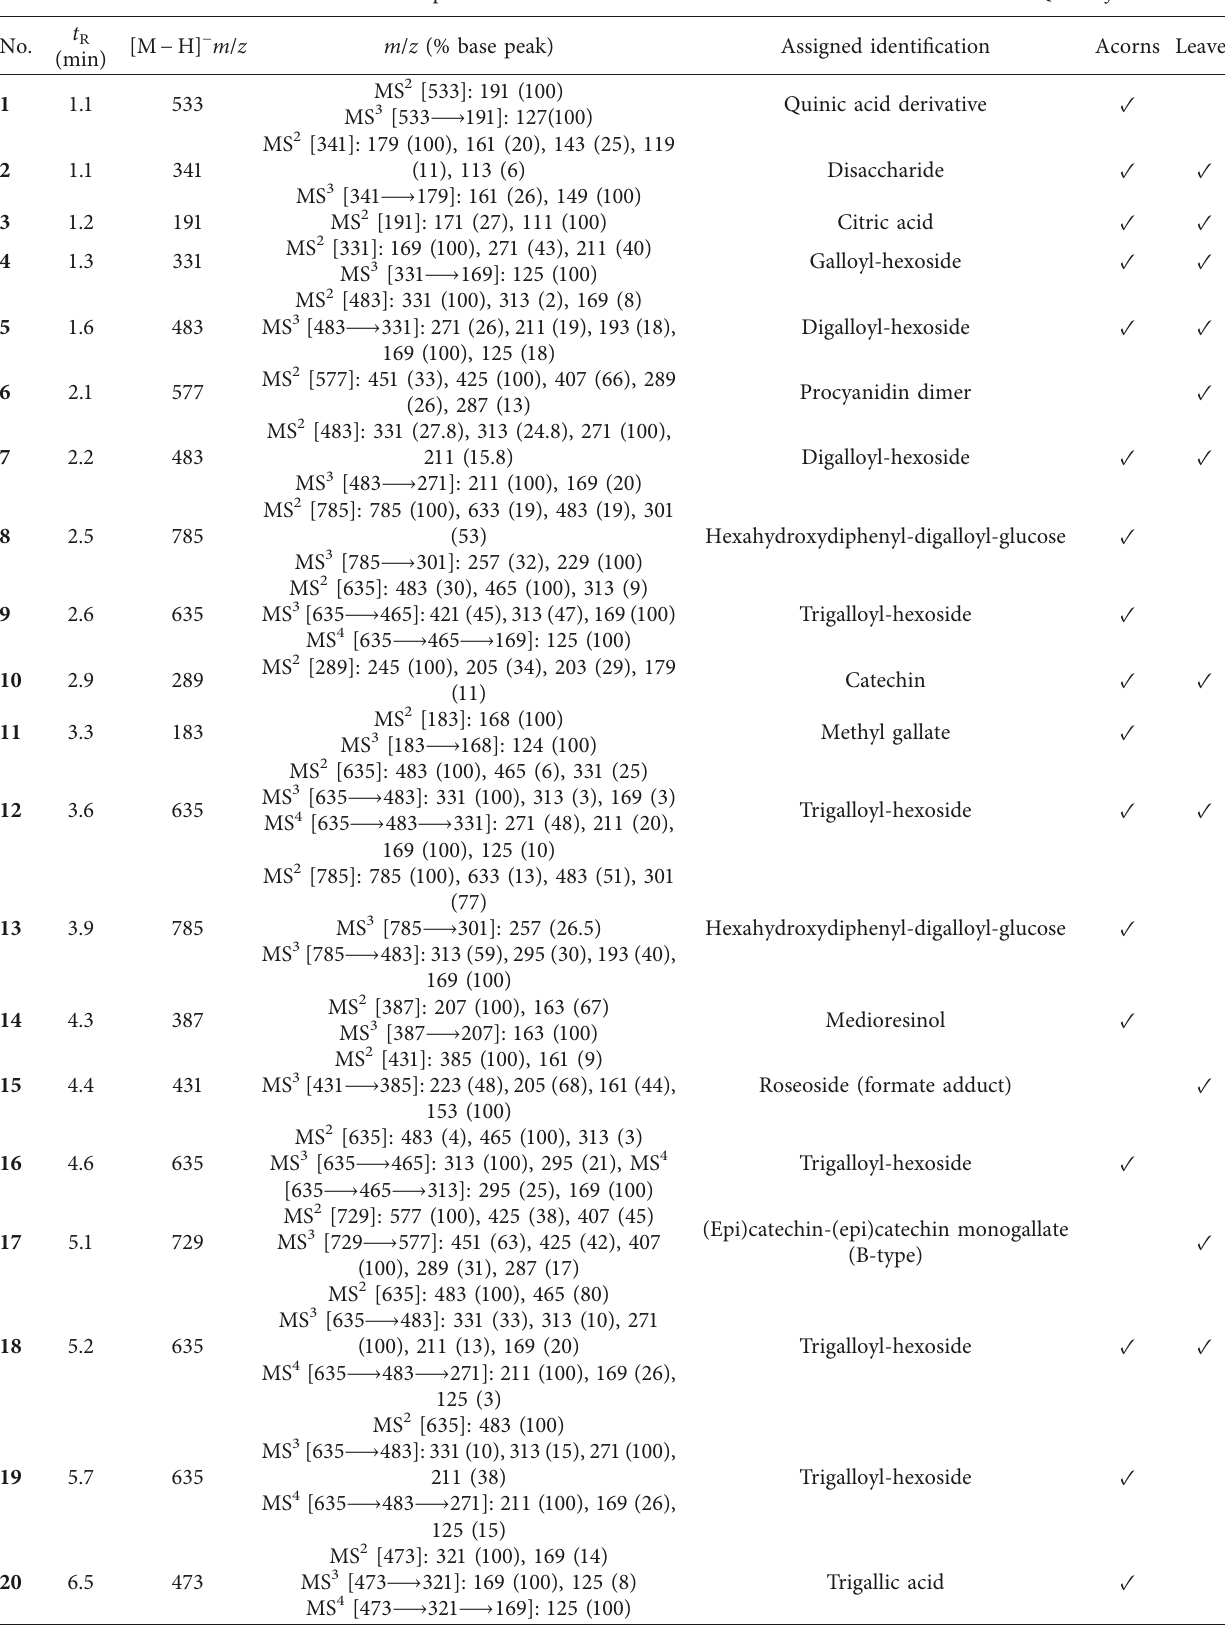
Table 1: Characterization of the compounds found in the methanolic extracts of acorns and leaves of Q. coccifera .